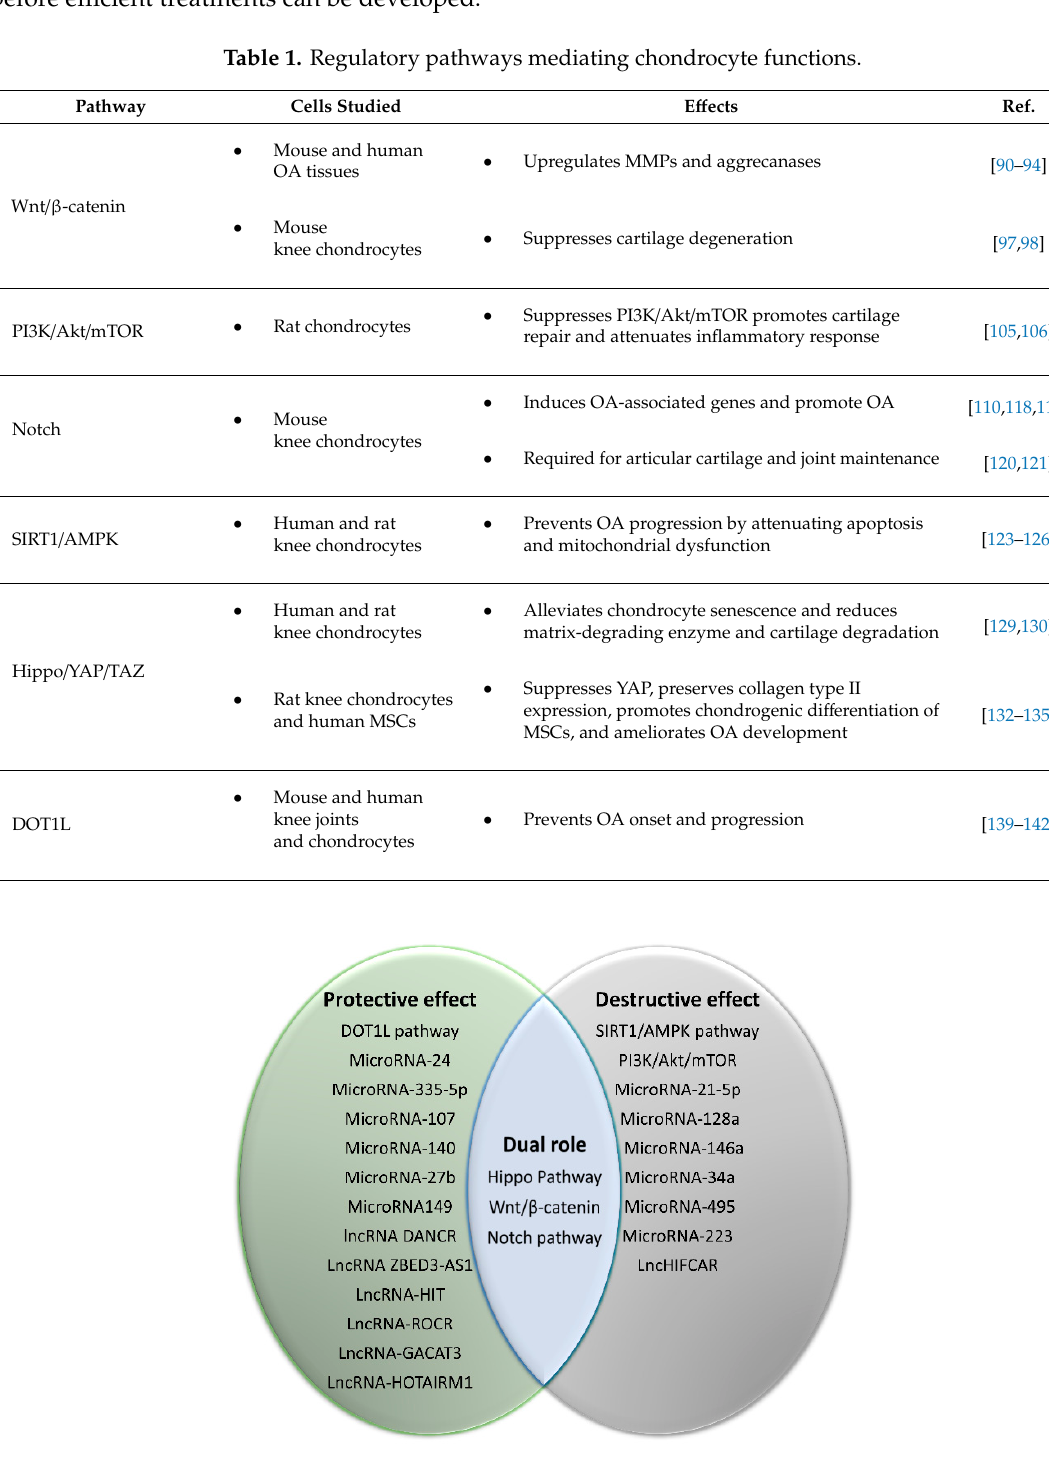
Table 1. Regulatory pathways mediating chondrocyte functions.